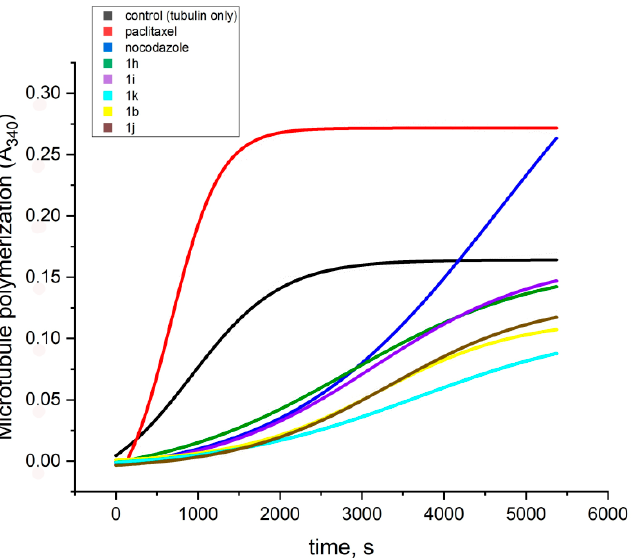
Figure 3. Porcine brain tubulin (final 70 µM) in presence of PB-GTP buffer, 10 µM paclitaxel, 10 µM nocodazole and 10 µM of the assayed compounds. Reaction was conducted in thermostated spec- trophotometric chamber at 37 °C for 90 min. Turbidity was measured at 340 nm every 30 s.